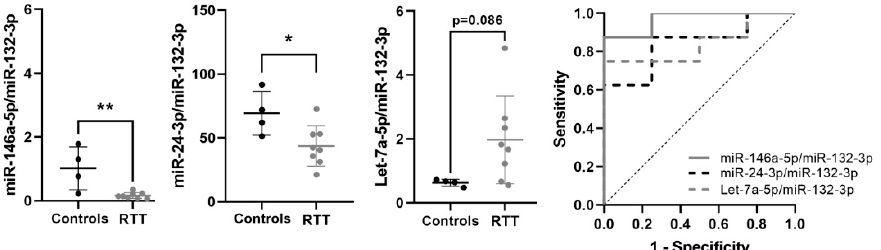
Figure 4. Validation of selected miRNA biomarkers in fibroblasts primary cultures. Graphs showing